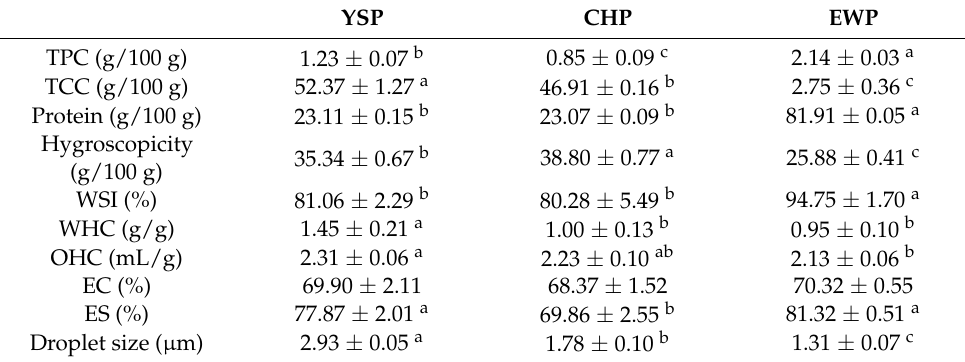
Table 1. Total polyphenol content (TPC), total carbohydrate content (TCC), protein, hygroscopicity, water solubility index (WSI), water-holding capacity (WHC), oil-holding capacity (OHC), emulsion capacity (EC), emulsion stability (ES), and mean droplet size of yellow soybean powder (YSP), chickpea powder (CHP), and egg white powder (EWP). YSP